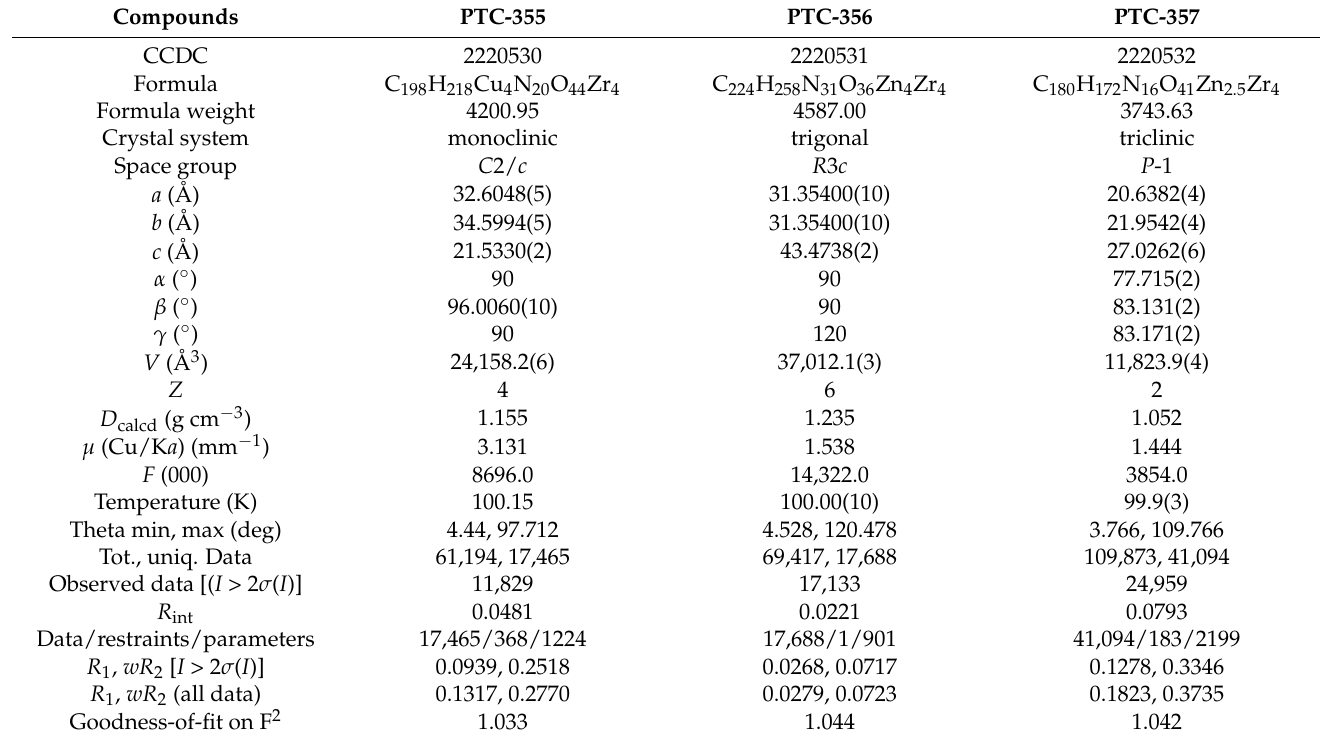
Table 1. Crystallographic Data and Structure Refinement Details for PTC-355 – PTC-357 .